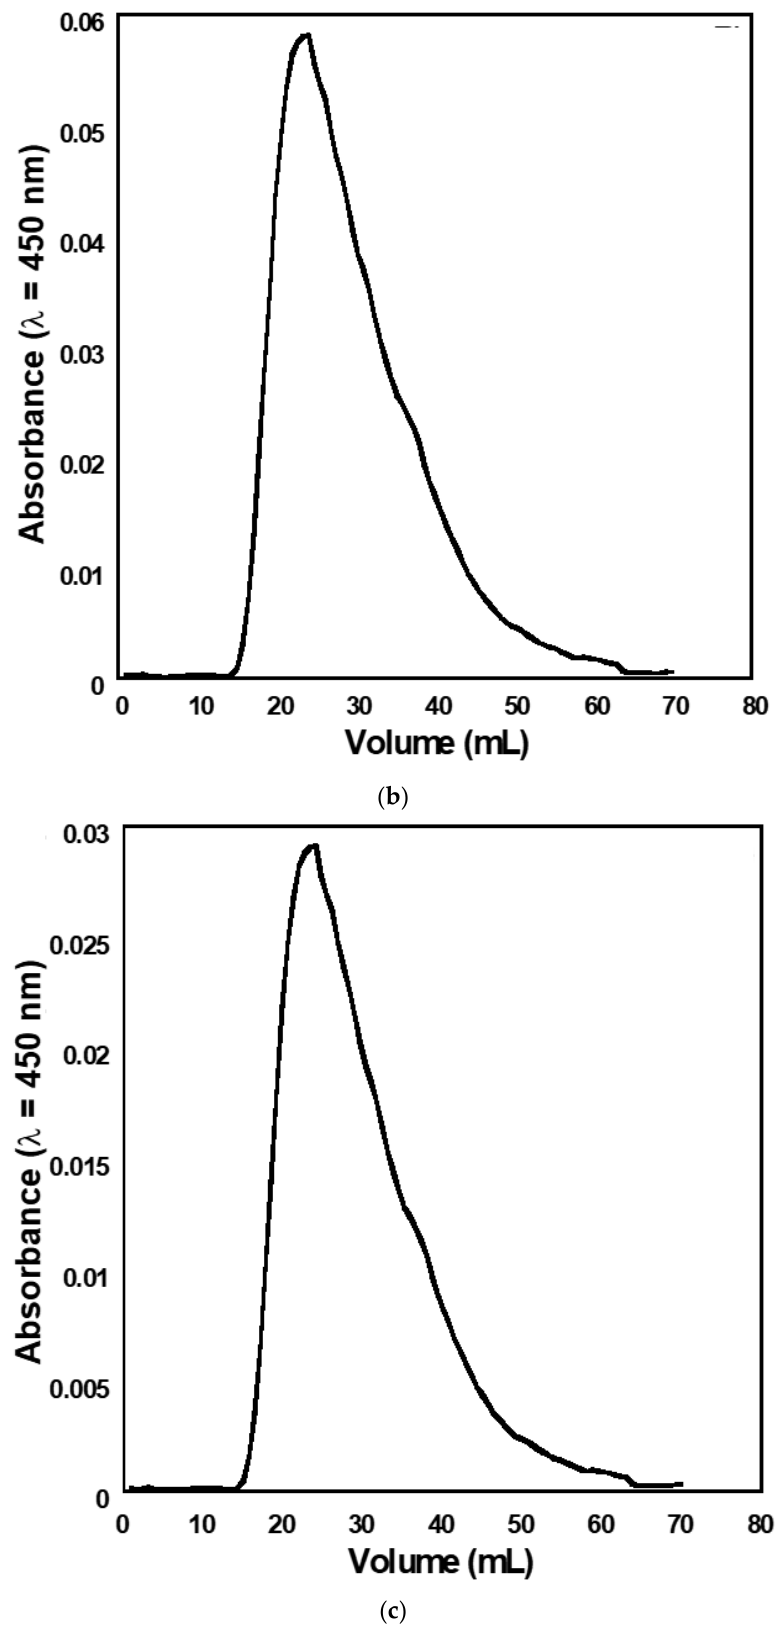
Figure 1. Low-pressure size exclusion chromatograms of humic acids (HA). Initial HA concentration